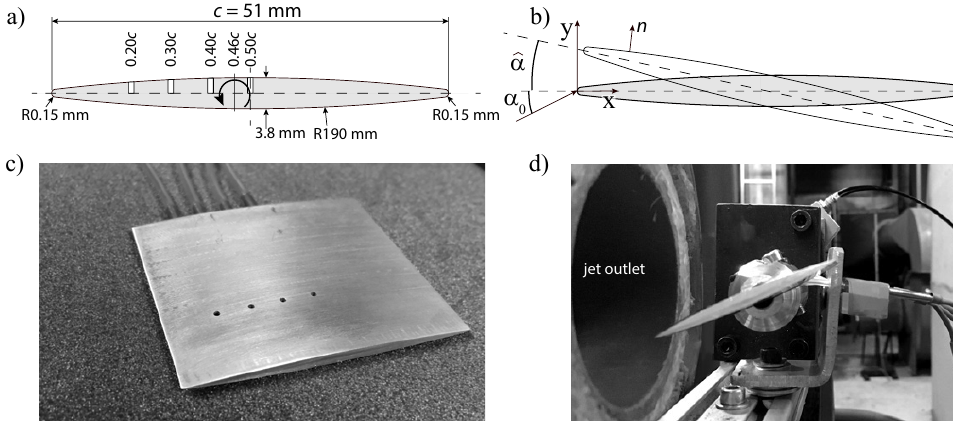
Figure 1. Schematic of blade profile and test setup. ( a ) sketch of geometry, ( b ) coordinate convention, ( c ) image of instrumented blade, ( d ) installation on oscillation